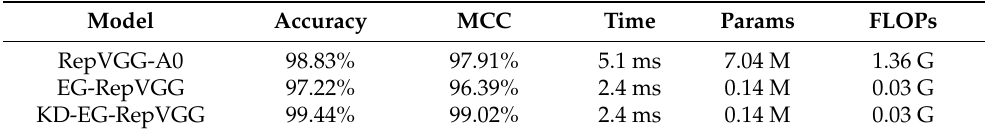
Table 3. Comparative experimental results of distillation.